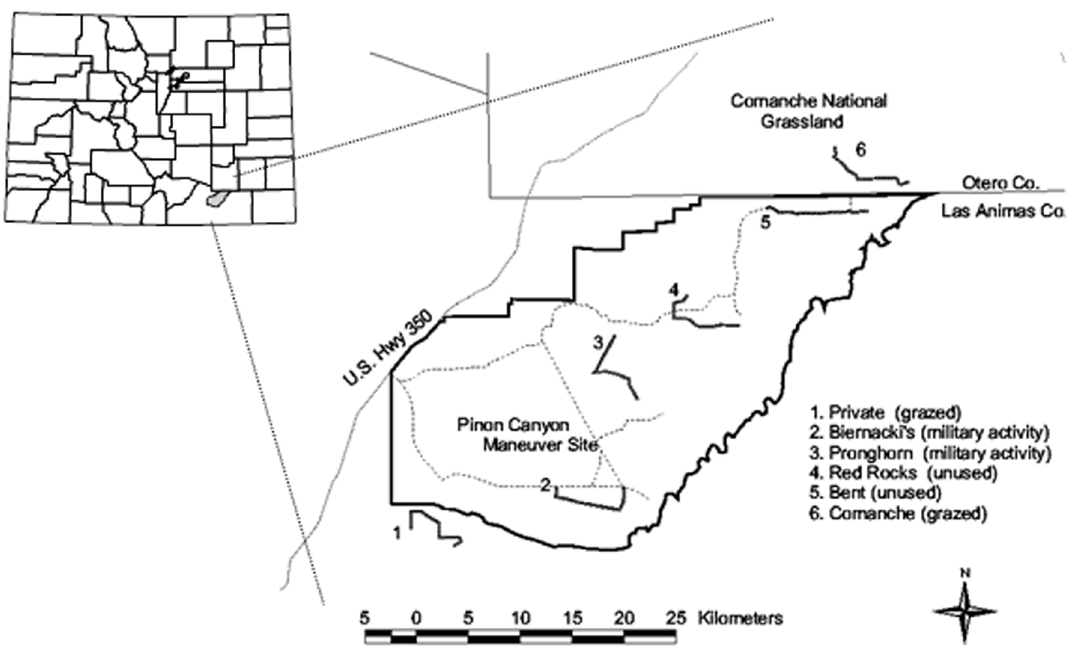
Figure 1. Six study sites on and around the Pin˜on Canyon Maneuver Site, southeastern Colorado, USA. Locations of the 6 transects are indicated, as well as the associated dominant land use.